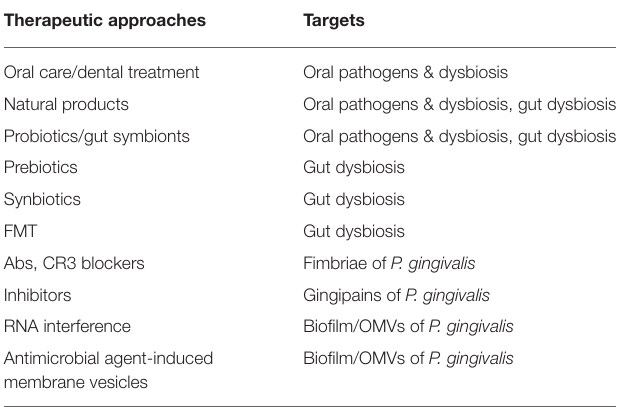
TABLE 3 | Therapeutic approaches in NAFLD targeting oral pathogens and oral/gut microbial dysbiosis.